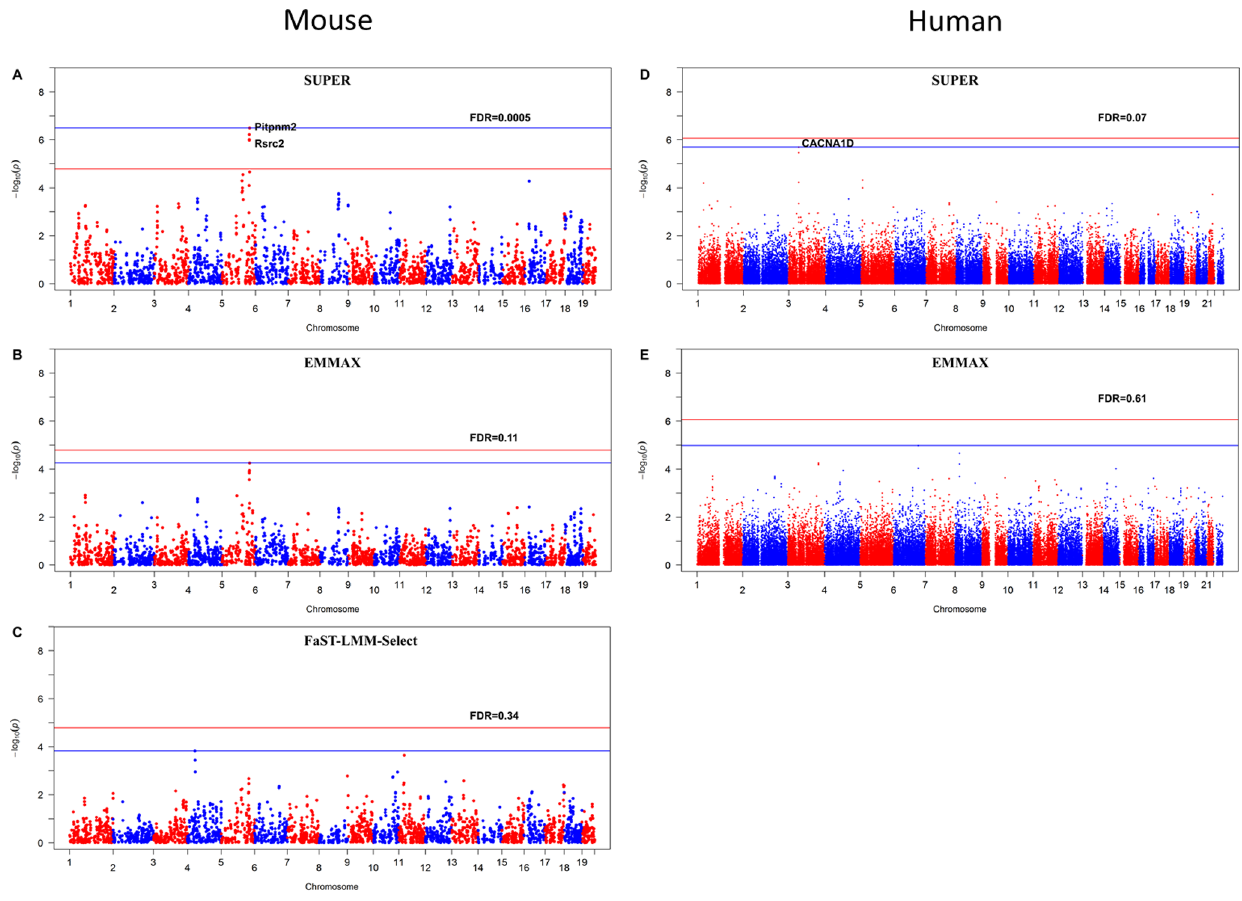
Figure 3. Results of association studies on real mouse and human phenotypes. The mouse phenotype is methamphetamine-induced locomotor activity on day 3 measured on 688 Advanced Intercross Lines (AIL). The human phenotype is cholesterol collected by the Framingham Heart Study (FHS) Project. Each dataset was analyzed with three different methods (SUPER, EMMAX, and FaST-LMM-Select) except the combination between FaST-LMM-Select and human data. The missing genotypes in the human data were imputed in format of dosage, which is not accepted by FaST-LMM-Select. The most significant SNP is highlighted by a horizontal blue line and labeled by its corresponding False Discover Rate (FDR). The p value threshold of 0.05 (after bonferroni multiple test correction) is indicated by a horizontal red line.